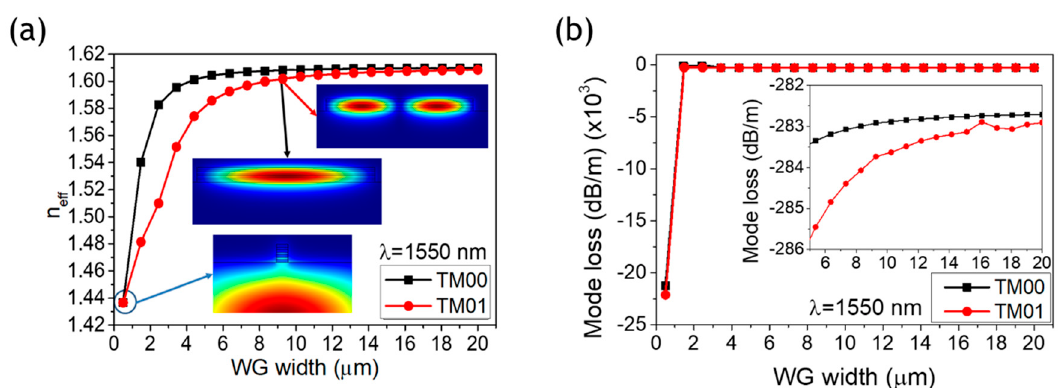
Figure 4. ( a ) n eff vs. WG width for TM00 and TM01 is plotted. Inside the plot, different simulated profiles of the fundamental TM modes for a WG width of 9 µ m at 1550 nm are shown. ( b ) Mode loss calculated for that range of WG widths is shown. The inset shows a zoom for the range of WG widths between 5 µ m and 20 µ m. These values were obtained for a multilayer WG with 3 SiO2 layers and 4 SiN layers.